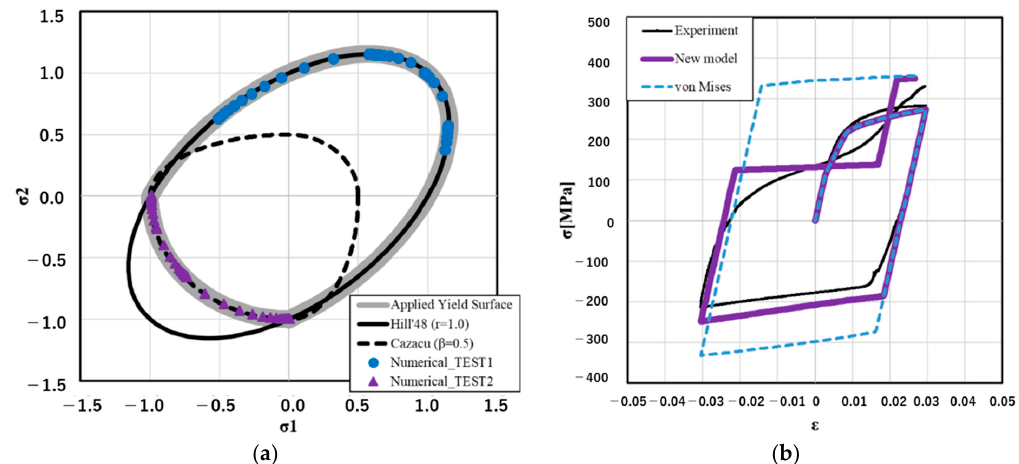
Figure 2. Validation of the newly implemented material model: ( a ) normalized yield surface; ( b ) cyclic stress-strain history.